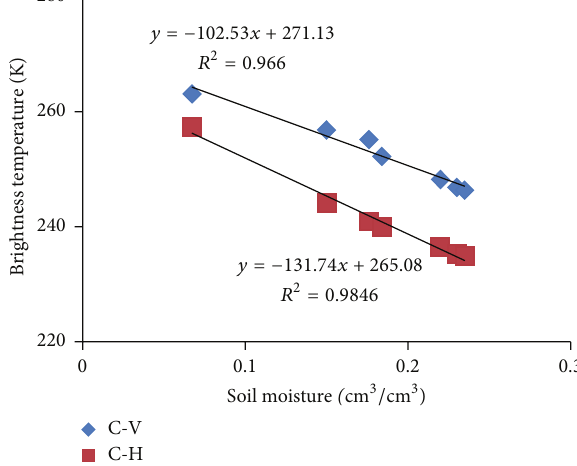
Figure 3: The change in C-band brightness temperature at both H and V polarization with field soil moisture at bare soil test